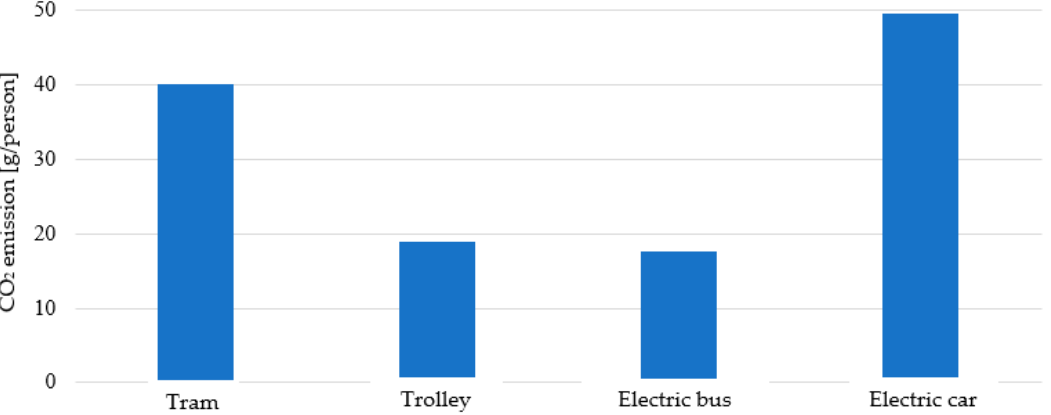
Figure 2. The amount of CO 2 emission during production of electric energy necessary for travel by each transport mode per one passenger.